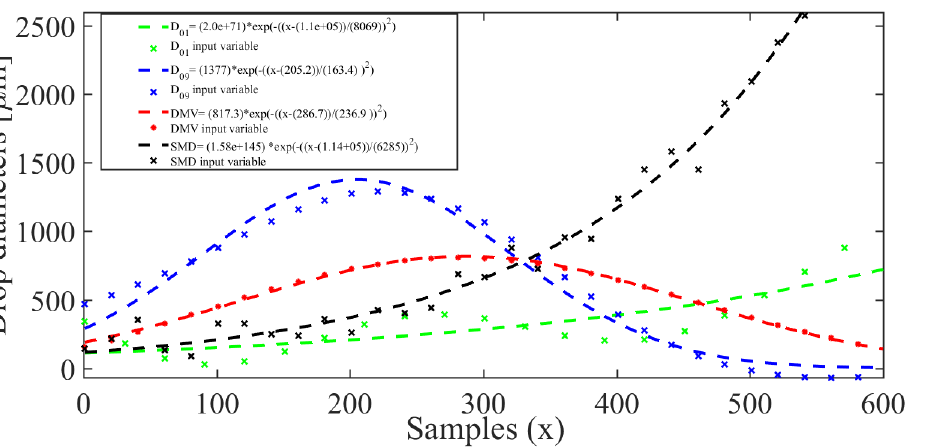
Figure 9. Gaussian curves of interpolation for mean and median diameter